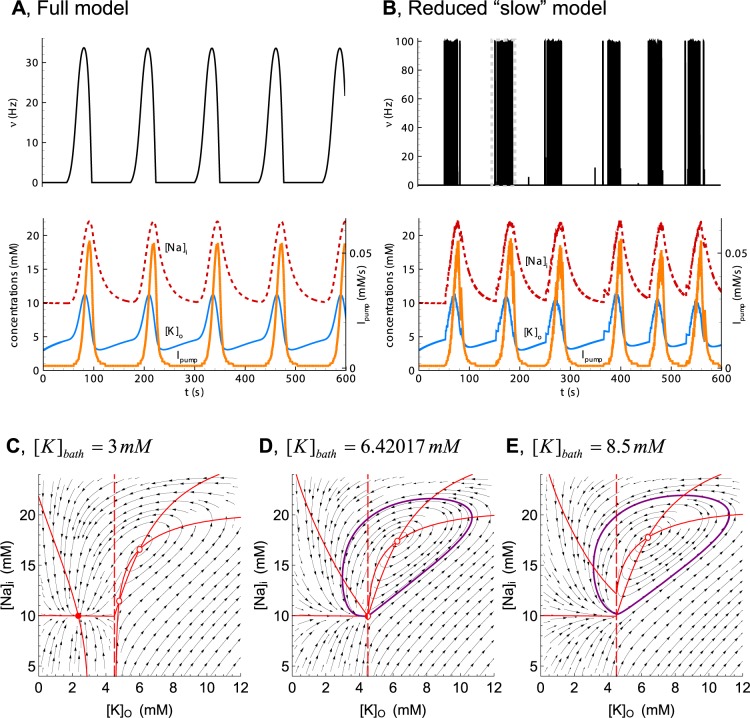
Slow subsystem producing IDs.(A) IDs in the full Epileptor-2 model. (B) Oscillations in the reduced model based on Eqs 1’, 2’, 5” and 8’. The plots repeat those in Fig 4. (C, D, and E) Phase portraits of the reduced model obtained for [K]bath = 3, 6.42017, and 8.5 mM, correspondingly. Note the stable node in C and the limit cycle around the unsteady focus in D.